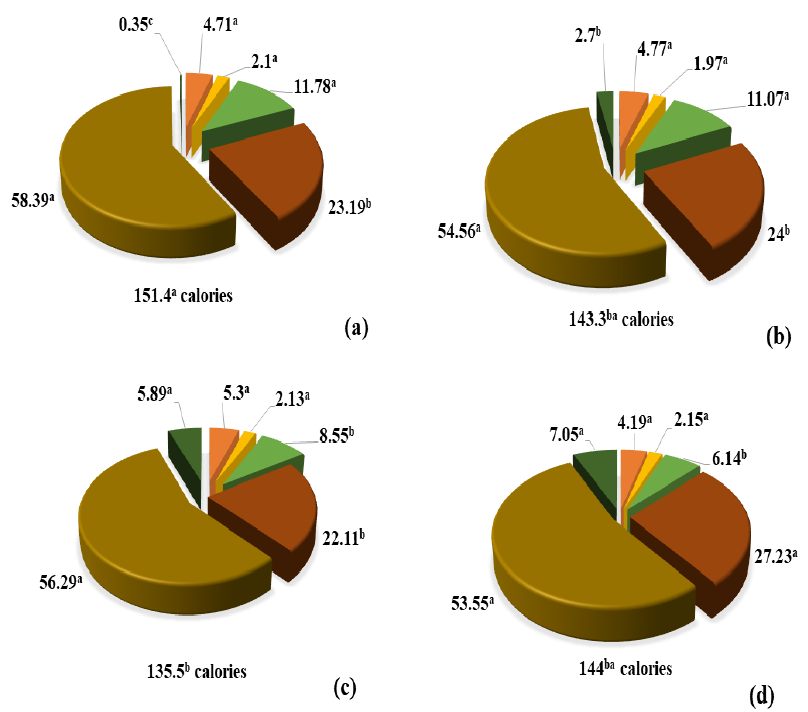
Figure 3. Chemical and nutritional analyses of the energy snacks, prepared with vegetable protein mixtures. ( a ) PC, ( b ) PC65 ® , ( c ) PB, and ( d ) control. Different letters among components are statistically different ( p < 0.05). Total calories were calculated for a 30 g portion.